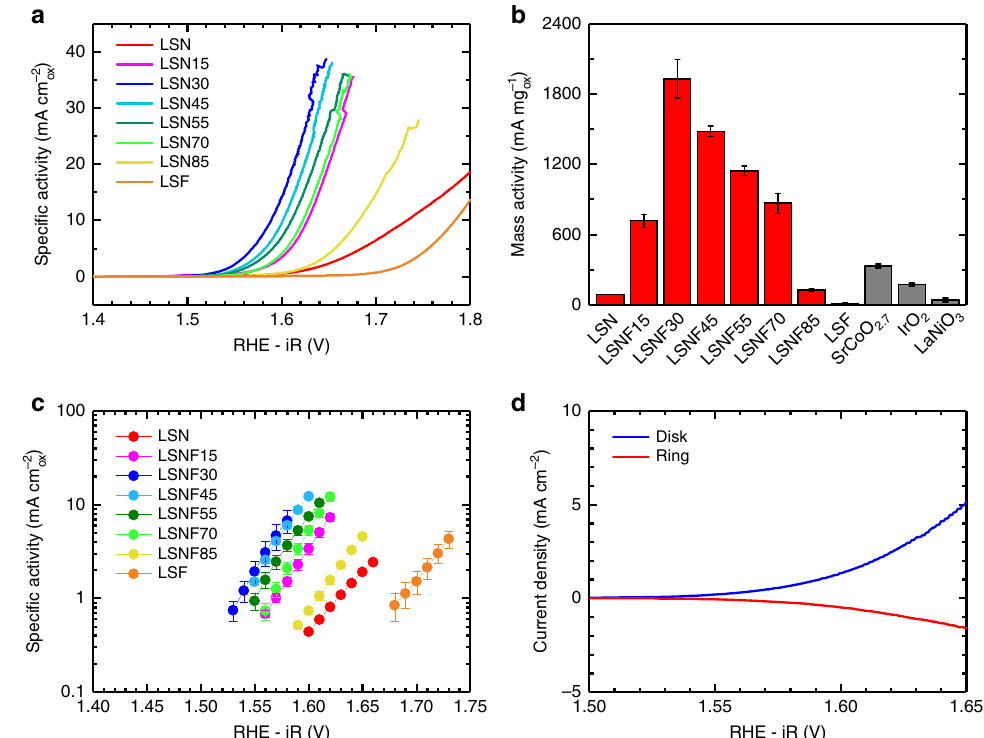
Fig. 2 Oxygen evolution results and catalytic activities for the LSNF series supported at 30 wt% on XC72 Vulcan carbon (VC). Activities measured in O 2 -saturated 0.1 M KOH at 10 mV s − 1 and 1600 rpm. a Averaged (anodic and cathodic) OER polarization curves presented in geometric current density (5 mm GCE, A = 0.196 cm 2 ). b Oxide mass activities of the LSNF series at 1.63 V vs RHE-iR compared to leading OER catalysts SrCoO 2.7 , LaNiO 3 , and IrO 2 on VC, all tested in the same experimental setup and conditions. Error bars are the standard deviations of measurements performed in triplicate. c Tafel plots of the speci fi c activity of each LSNF catalyst. Error bars are the standard deviations of measurements performed in triplicate d RRDE test to con fi rm that current is due to oxygen evolution. The disk has a thin layer of 30 wt% LSNF30/VC and the ring is Pt. O 2 generated at the disk is then reduced back to OH − at the ring which is poised at − 0.4 V vs Hg/HgO (1 M). The collection ef fi ciency of the RRDE at 1.63 V was found to be 34%. RRDE measurements were performed in Ar-saturated 0.1 M